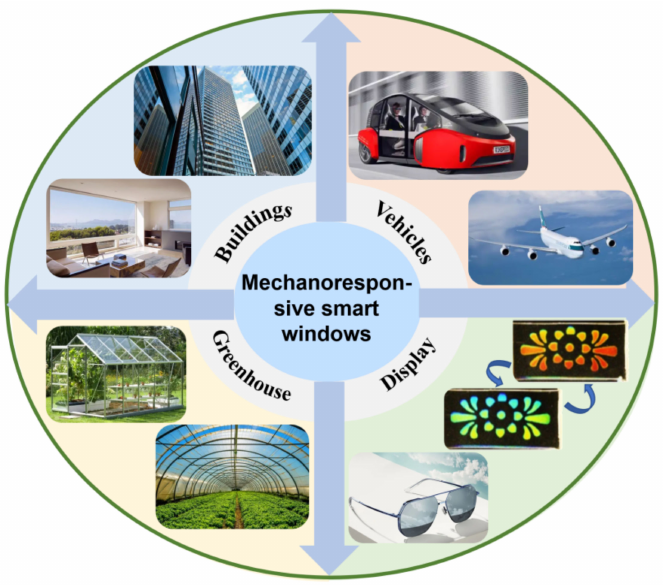
Figure 13. Potential applications of mechanoresponsive smart